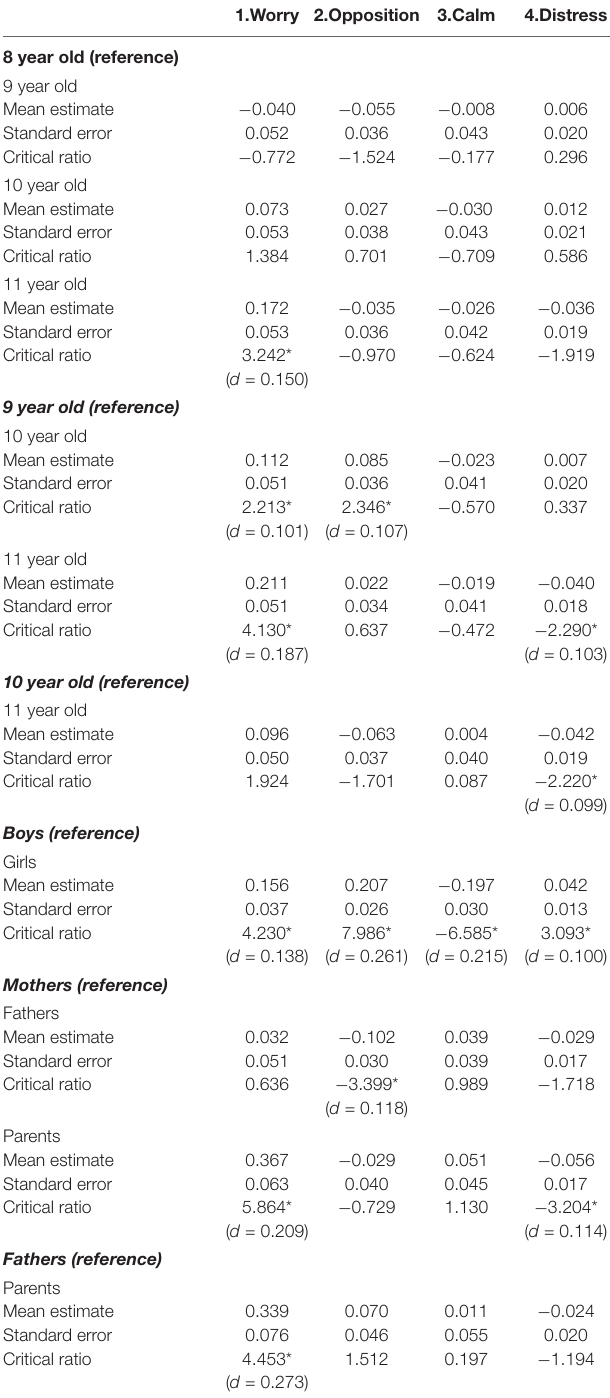
TABLE 7 | Scores of latent mean differences across child’s age and gender, and